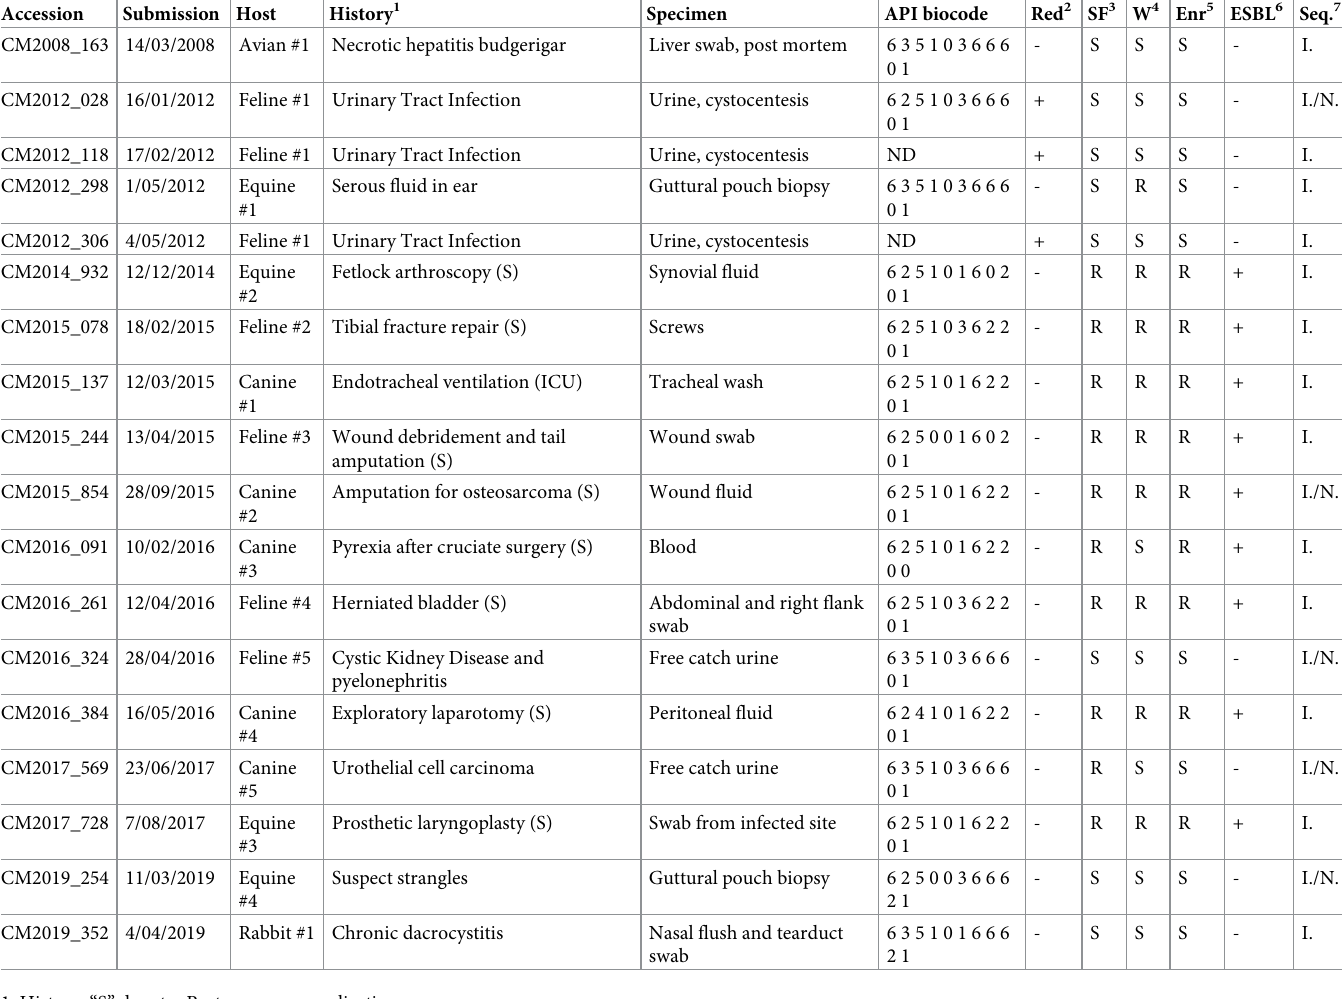
Table 1. Clinical history and key phenotypic characters of Serratia spp.